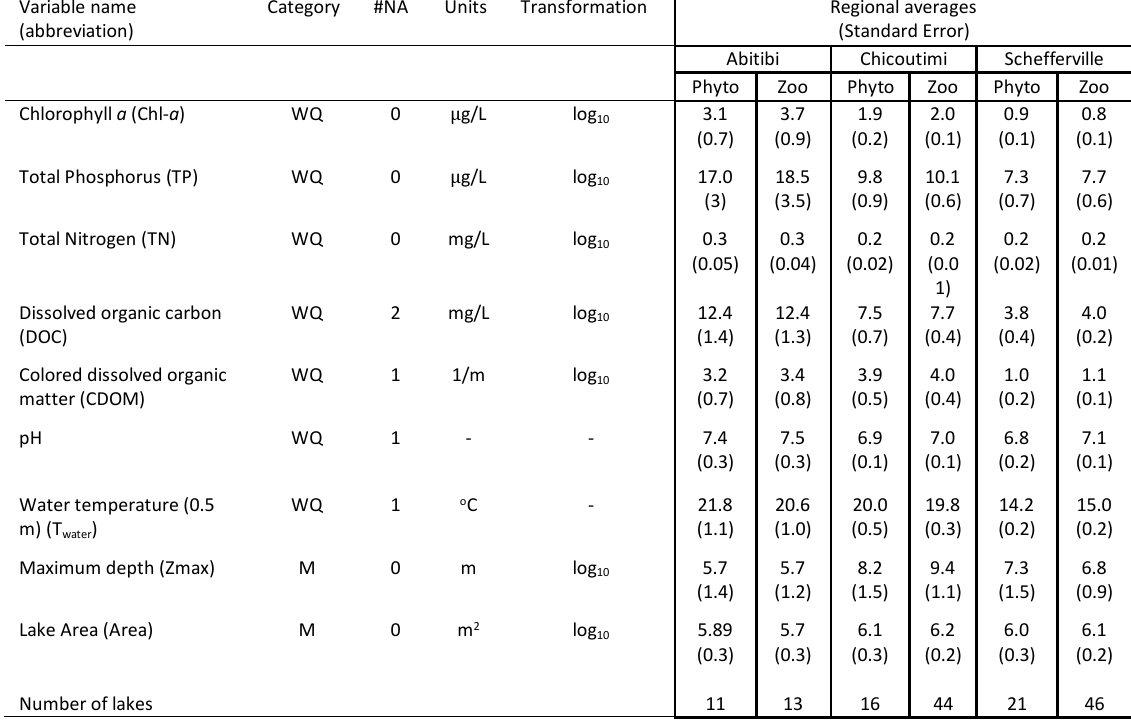
Table 1: Means and standard error (SE, in parenthesis) of environmental variables by region for the 48 phytoplankton lakes (Phyto) and the 104 zooplankton lakes (Zoo). Environmental variables are classified as either water quality (WQ) or morphometric (M) types. The number of missing values (#NA), measurment units and the transformations used are also